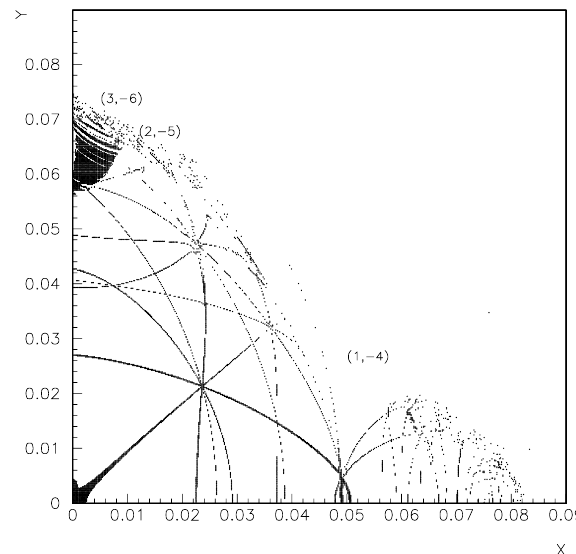
FIG. 5. Network of resonances of the uncoupled Hénon map.